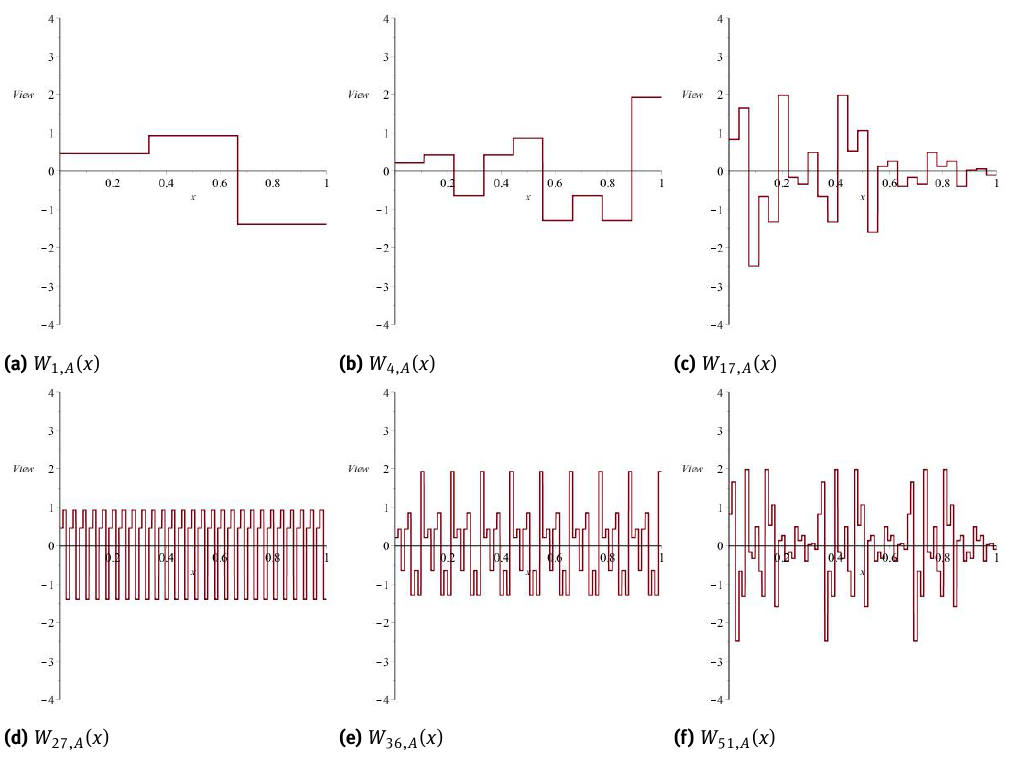
Figure 1: The plots of six general Walsh functions associated corresponding to